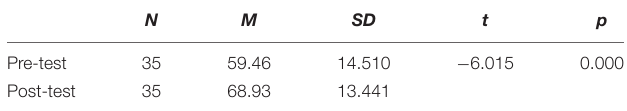
TABLE 9 | The paired sample T -test of English